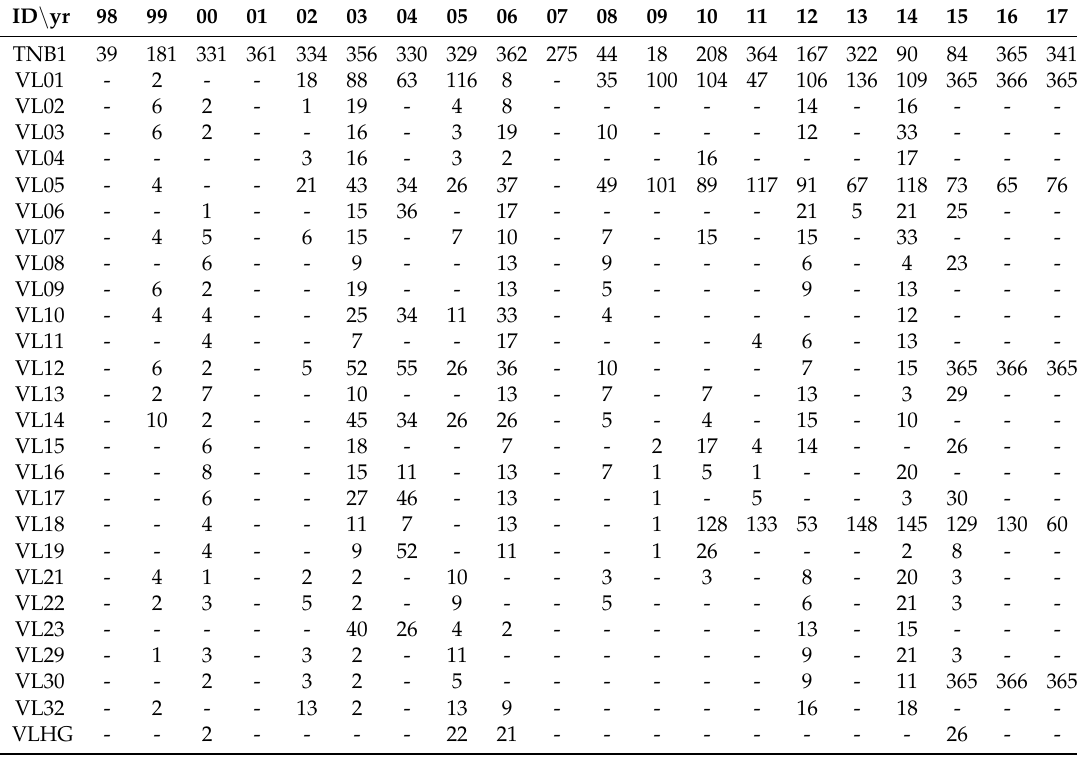
Figure 3. Locations of the 208 GNSS stations distributed worldwide and providing data under the supervision of different projects and institutions: VLNDEF (ftp://ftp.ira.inaf.it/pub/ogia/), Polar Earth Observing Network (POLENET) (ftp://data-out.unavco.org/pub/rinex/obs/) and International GNSS Service (IGS) (ftp://igs.ensg.ign.fr/pub/igs/data/); Supplementary Materials available, Tables S1–S3); yellow triangles identify IGS stations adopted to define the geodetic datum within the processing of the GNSS data using Bernese GNSS software [26]. Table 1. Occupation (days) of VLNDEF stations from 1998 to 2017.